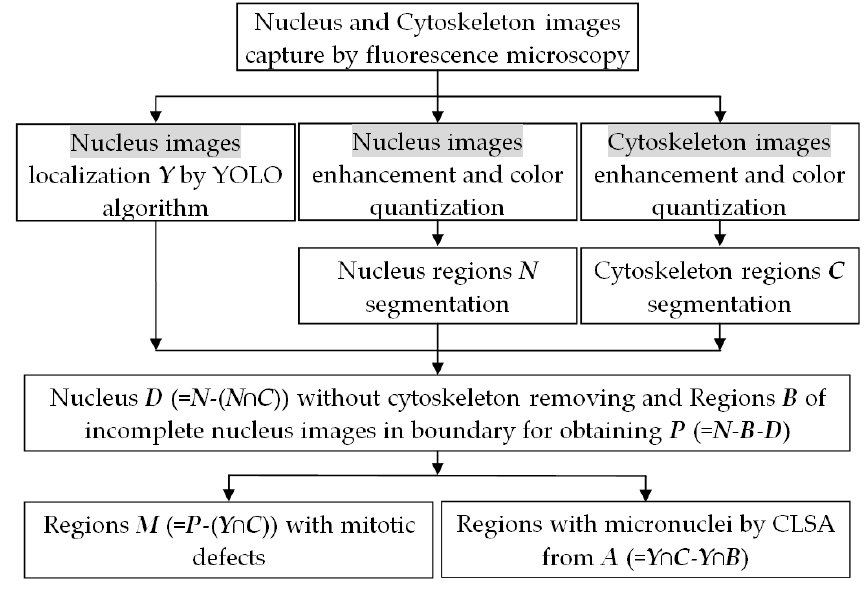
Figure 3. The processing procedure of the proposed method for the automatic cell detection of nuclei from a colon cancer image.